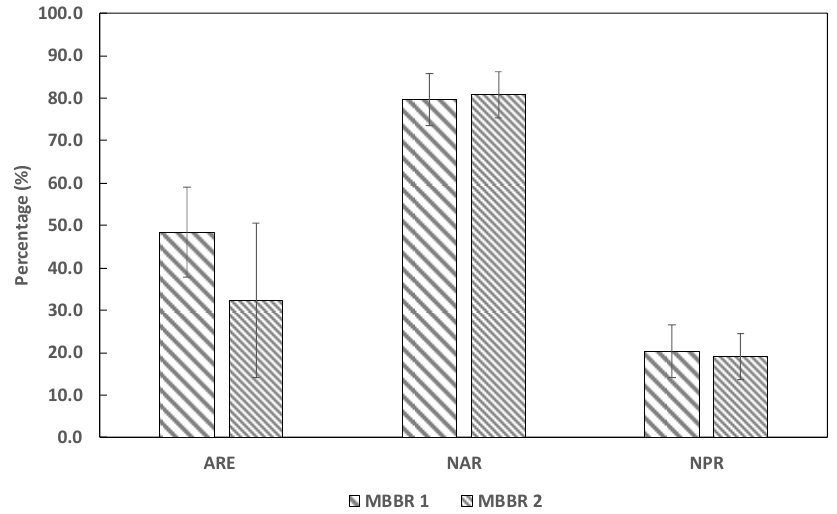
Figure 3. The ammonium removal efficiency (ARE), nitrite accumulation rate (NAR), and nitrate production rate (NPR) in both reactors ( n = 23).